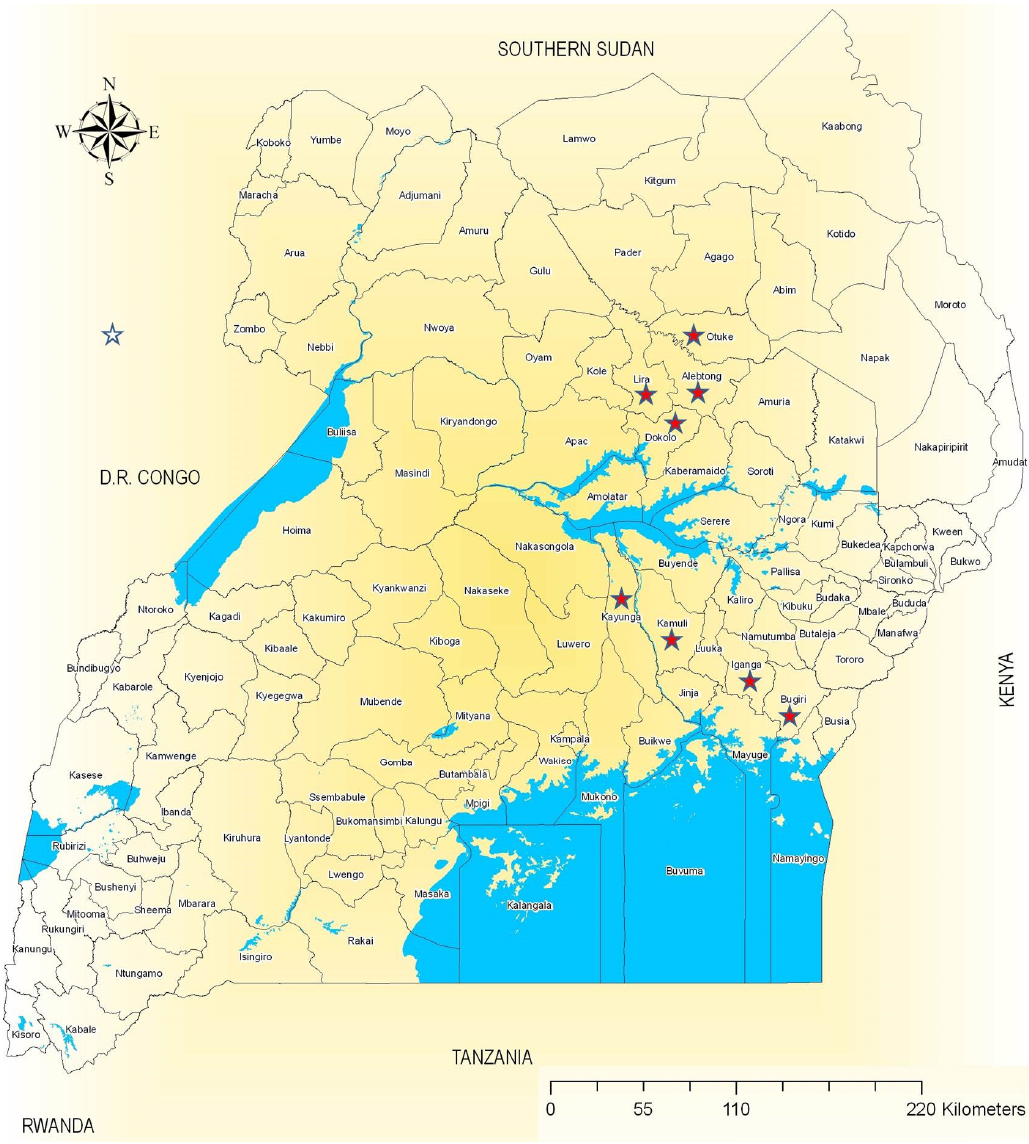
Figure 1. Map showing all districts in Uganda. Districts that were surveyed are marked with red stars.